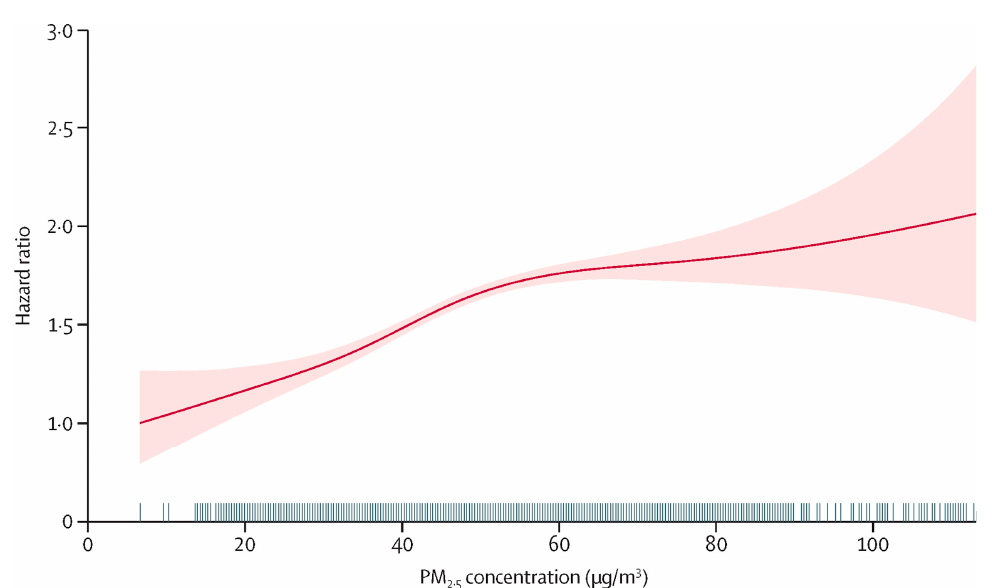
Figure A10. Model 1: Concentration-response (C-R) relationship between hazard ratio and PM 2.5 concentration. The red shaded area represents the standard deviation.